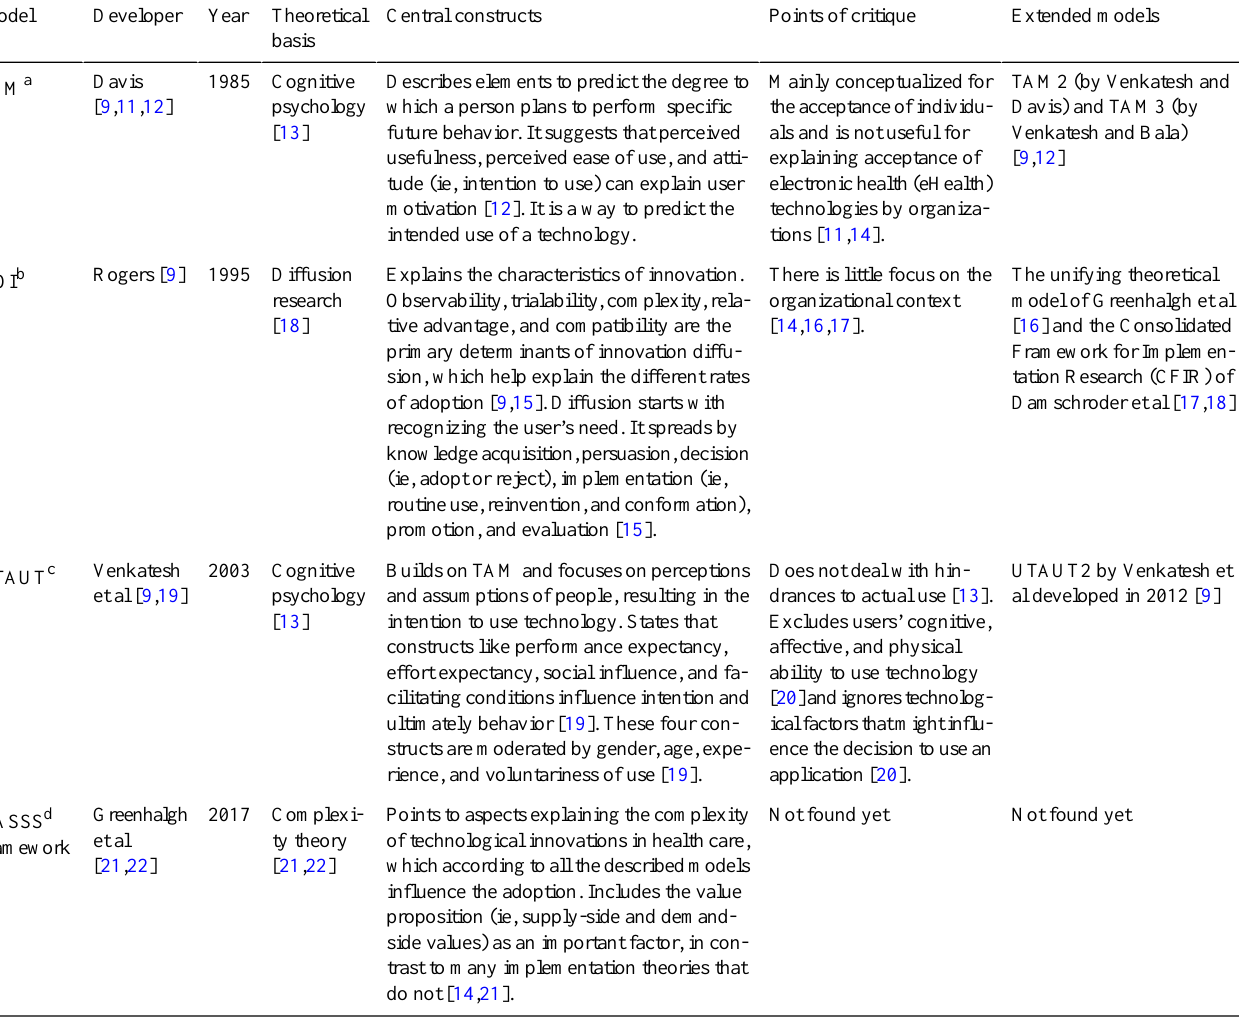
Table 1. Theoretical acceptance and adoption